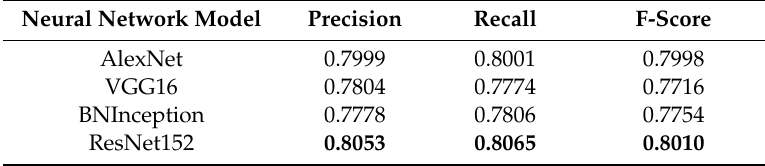
Table 4. Mean precision, recall, and f-score values of AlexNet, VGG16, BNInception, and ResNet152 neural network models used for transfer learning. The best results are shown in